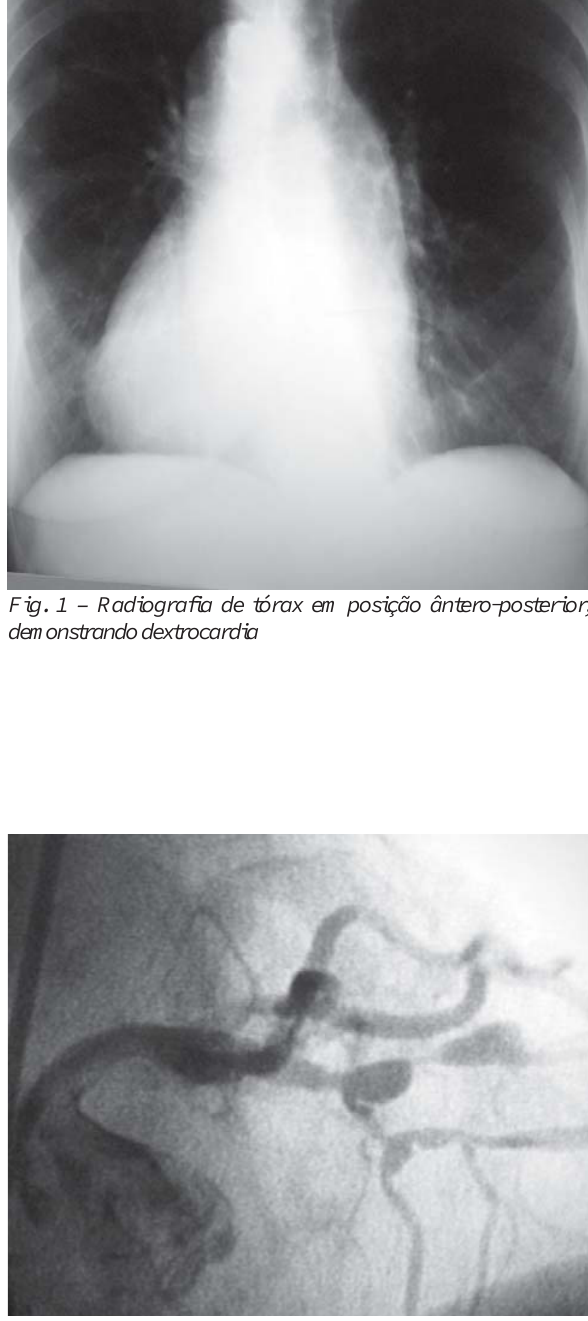
Fig. 2 - Cinecoronariografia com a imagem rotada (já corrigida) demonstrando lesões graves com aneurismas na artéria interventricular